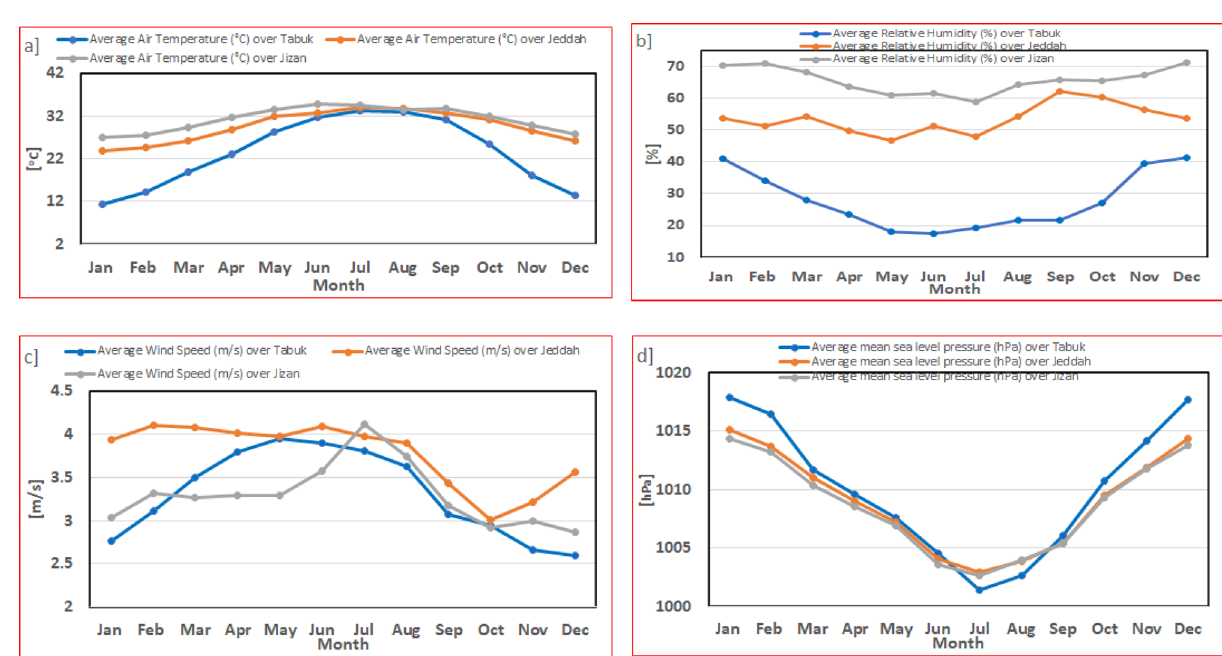
Figure 3. Observed short-term monthly means (annual cycle) for the parameters studied based on the hourly observed data